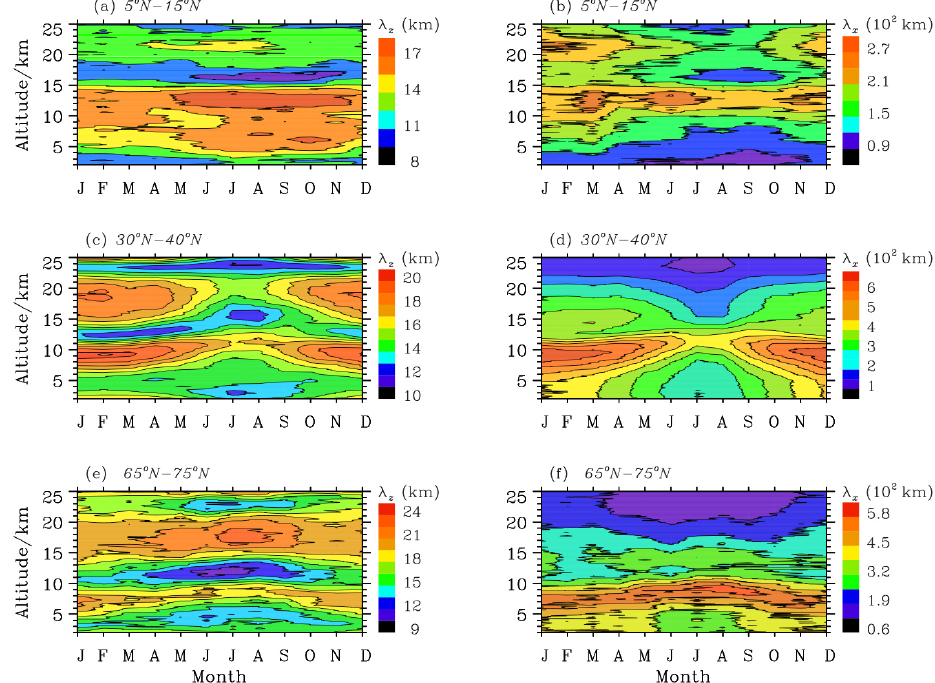
Figure 8. Annual variation of averaged vertical (left column) and zonal (right column) wavelengths at different latitudes. (a) , (c) and (e) denote annual variations of averaged vertical wavelengths of high-frequency gravity waves at low, middle and high latitudes, respectively; (b) , (d) and (f) denote annual variations of averaged zonal wavelengths of high-frequency gravity waves at low, middle and high latitudes, respectively.